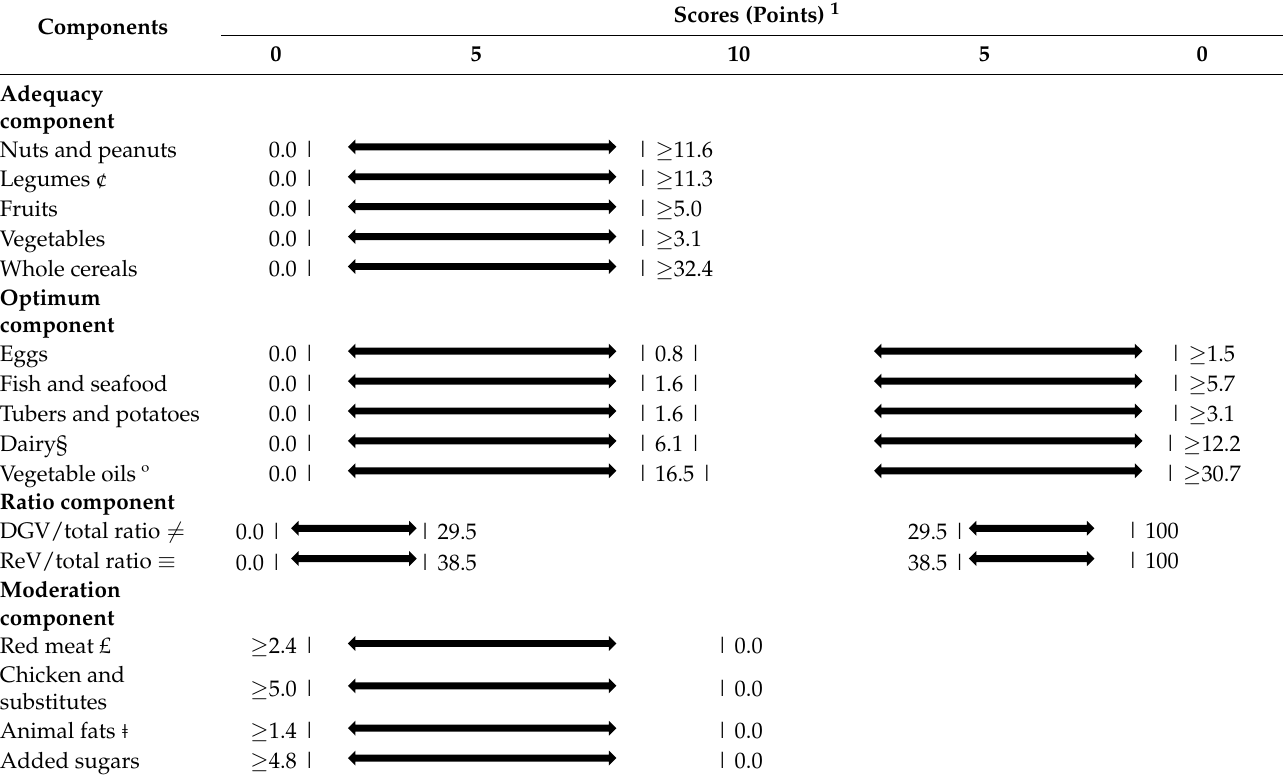
Table 1. Planetary Health Diet Index components, standards for scoring (caloric densities), and corresponding point values.